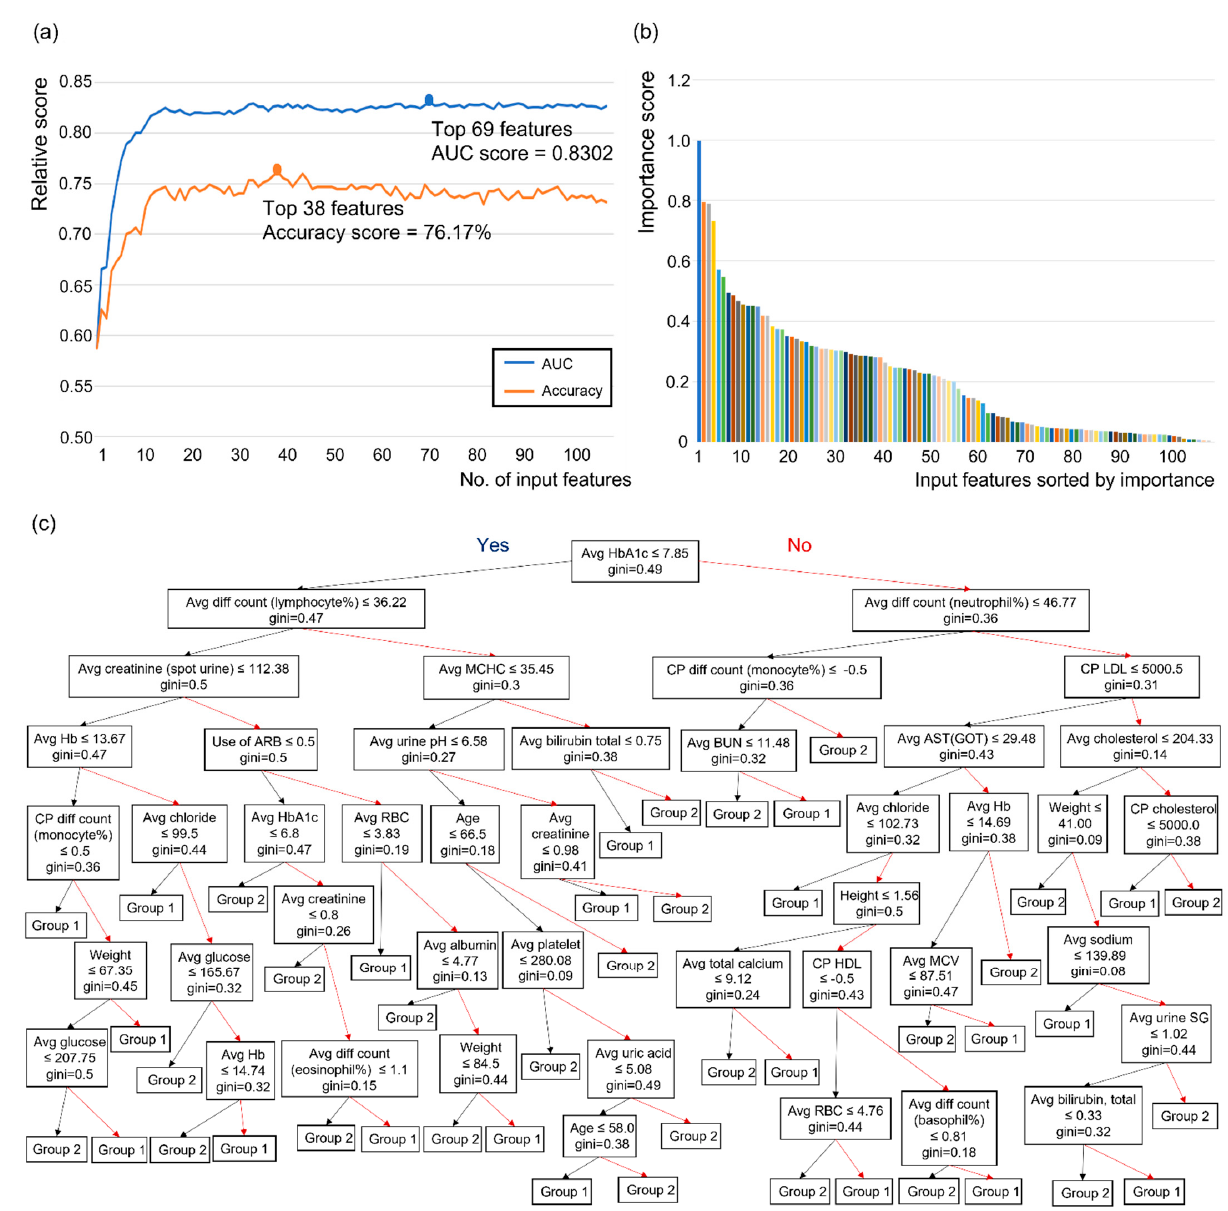
Figure 4. Application of random forest algorithm and process of extraction of important features in the classification of the combination of the normal, possible, and probable groups versus the confirmed group. ( a ) Model performance according to the number of input features sorted by importance, ( b ) the result of arranging input features in order of importance score, ( c ) a decision tree using the random forest algorithm with the classification of the combination of the normal, possible, and probable groups versus the confirmed group. Note: Group 1 = a group in which the normal, possible, and probable groups are combined, Group 2 = the confirmed group. Black arrow = positive results for the above features, red arrow = negative results for the above features, gini = gini index. Abbreviations: AUC = area under the curve; ALP = alkaline phosphatase; ALT (GPT) = alanine aminotransferase (glutamic pyruvate transaminase); AST (GOT) = aspartate aminotransferase (glutamic oxaloacetic transaminase); Avg = average; BST = blood sugar test; BUN = blood urea nitrogen; CP = change pattern; Diff = differential; T4 = thyroxine; Hb = hemoglobin; HbA1c = hemoglobin A1c; HCT = hematocrit; HDL = high-density lipoprotein cholesterol; IFCC = International Federation of Clinical Chemistry; LDL = low-density lipoprotein cholesterol; MCH = mean corpuscular hemoglobin; MCHC = mean corpuscular hemoglobin concentration; MCV = mean cell volume; PLT = platelet; RBC = red blood cell; TG = triglyceride; TSH = thyroid-stimulating hormone; SG = specific gravity; WBC = white blood cell.